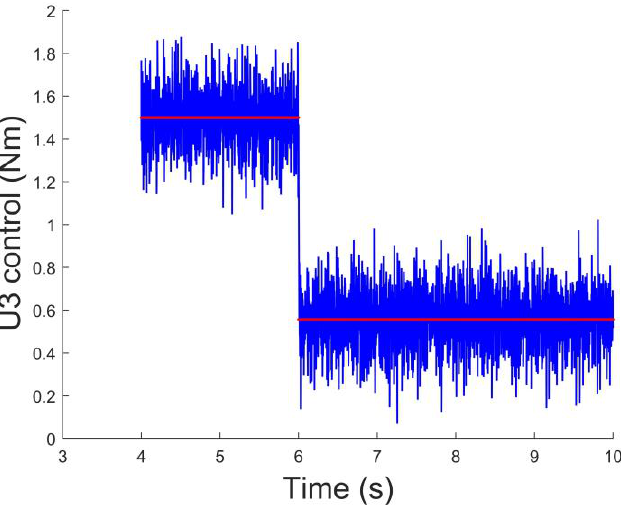
Figure 12. Simulation of control quantity of robot pitch channel.